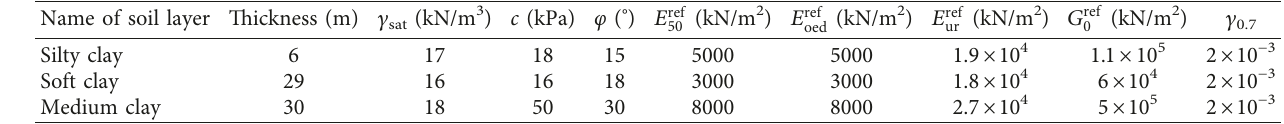
Table 1: Input parameters of the finite element method.